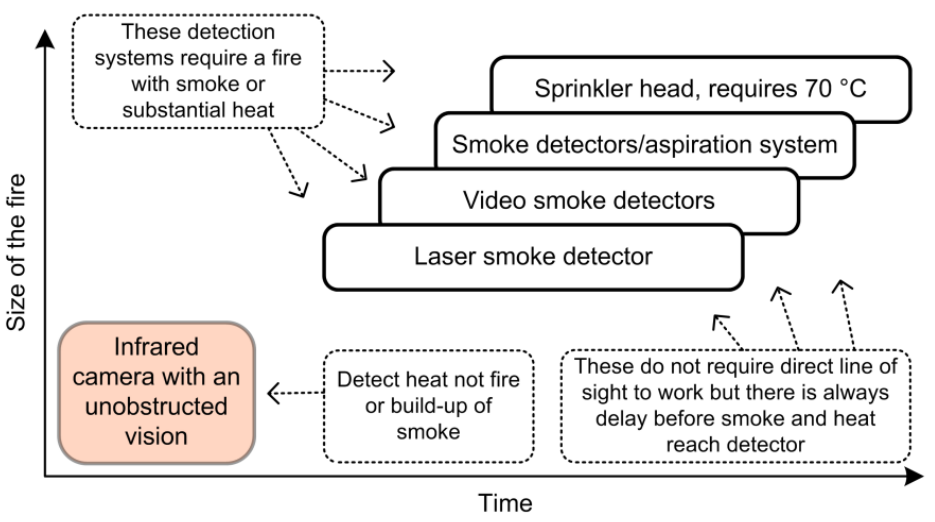
Figure 4. Fire-detection systems in relation to time and required size of fire before triggering [24].